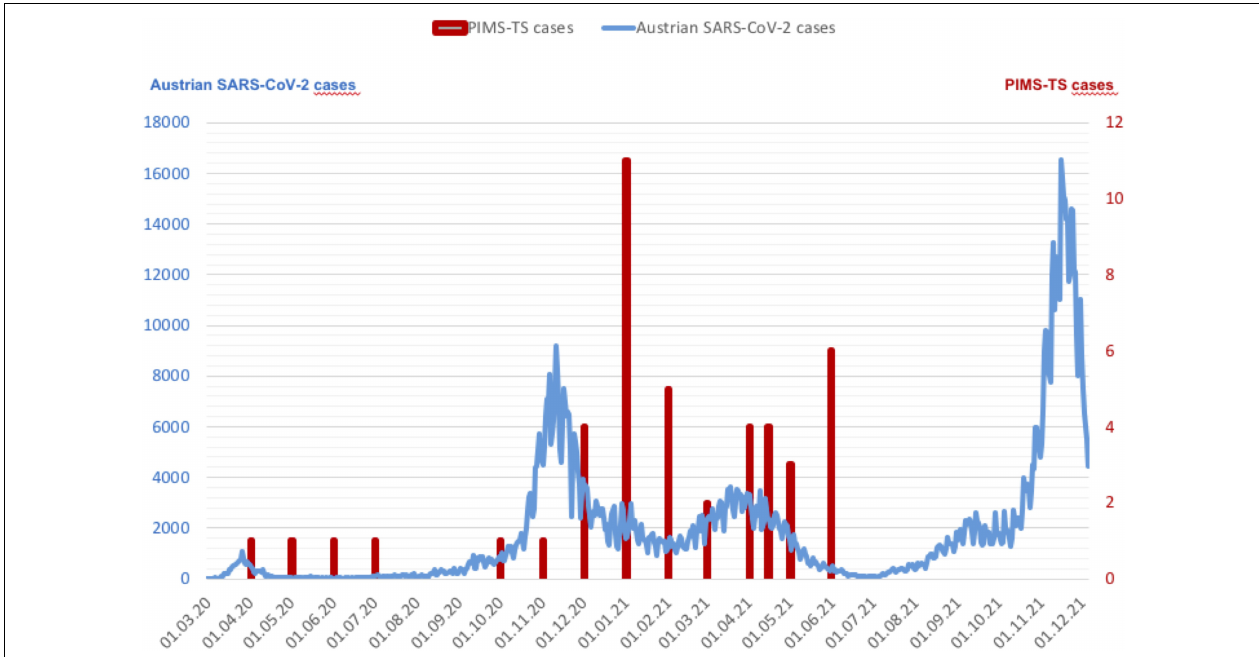
FIGURE 1 | The Graph demonstrates patients with PIMS-TS and Austrian COVID-19 cases ( blue curve , data from Statistic Austria) (29). Of the 45 children 39/45 (87%) patients presented with PIMS-TS between October 2020 and January 2021 ( n = 20) and February to May 2021 ( n = 19). The remaining 6/45 (13%) cases were reported between April and September 2020 ( red bars ).